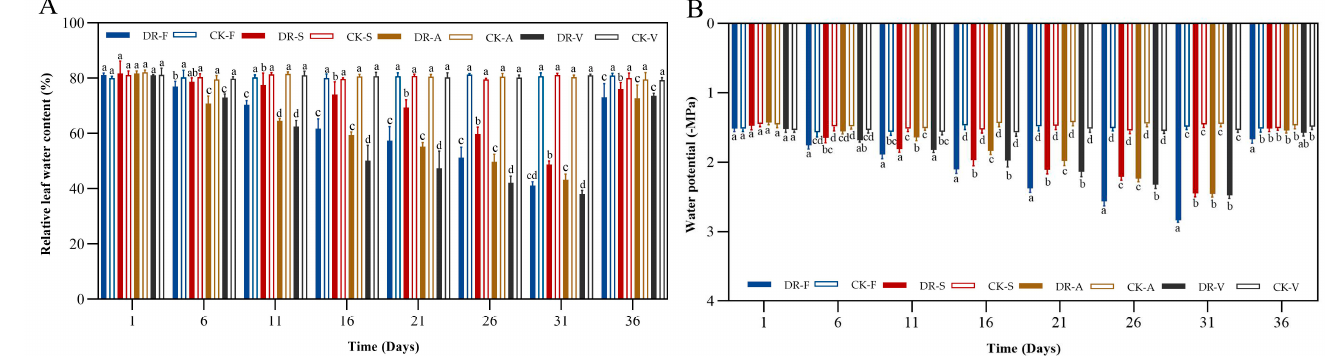
Figure 2. Effects of drought stress and rewatering on relative water content and water potential of four oak species. ( A ), relative water content ( B ), water potential. DR-F: drought-rewatering sample of Q. fabri ; CK-F: well watered sample of Q. fabri ; DR-S: drought-rewatering sample of Q. serrata ; CK-S: well watered sample of Q. serrata ; DR-A: drought-rewatering sample of Q. acutissima ; CK-A: well watered sample of Q. acutissima ; DR-V: drought-rewatering sample of Q. variabilis ; CK-V: well watered sample of Q. variabilis . Different lowercase letters indicate significant ( p < 0.05) differences among the four oak species subjected to the same treatment time.